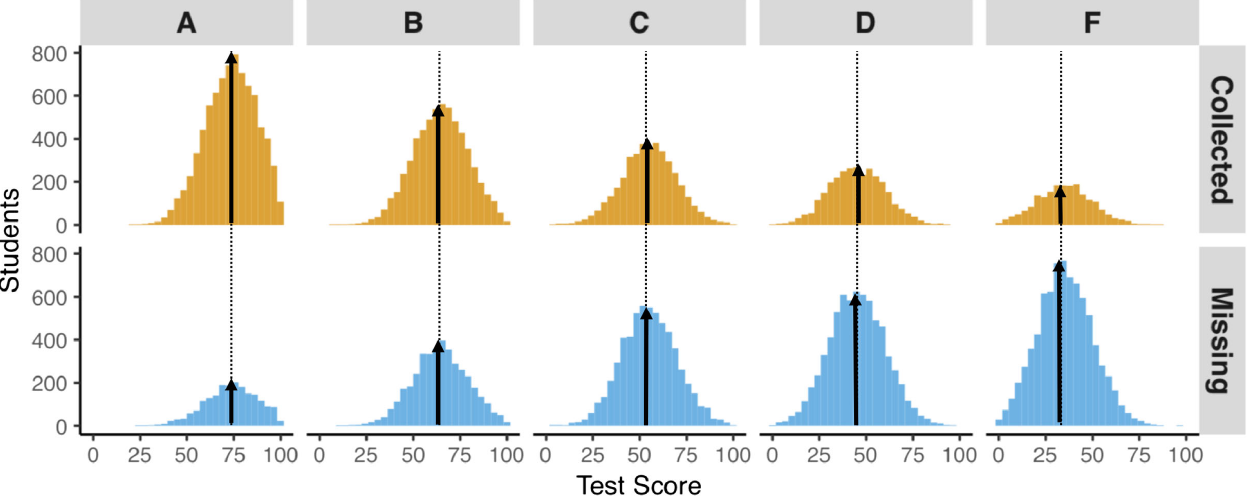
FIG. 3. The simulated concept inventory data shown in Fig. 1 disaggregated by student ’ s course grades. The similar distribution for each grade indicates that the data is MAR because course grade accounts for the missingness. We made the course grades follow a flat distribution ( N A ¼ N B ¼ N C ¼ N D ¼ N F ) to focus the differences between the collected and missing data on the similar distribution by grade that indicates the data is MAR and to illustrate how combining the data results in Fig. 1, where the collected and missing distributions